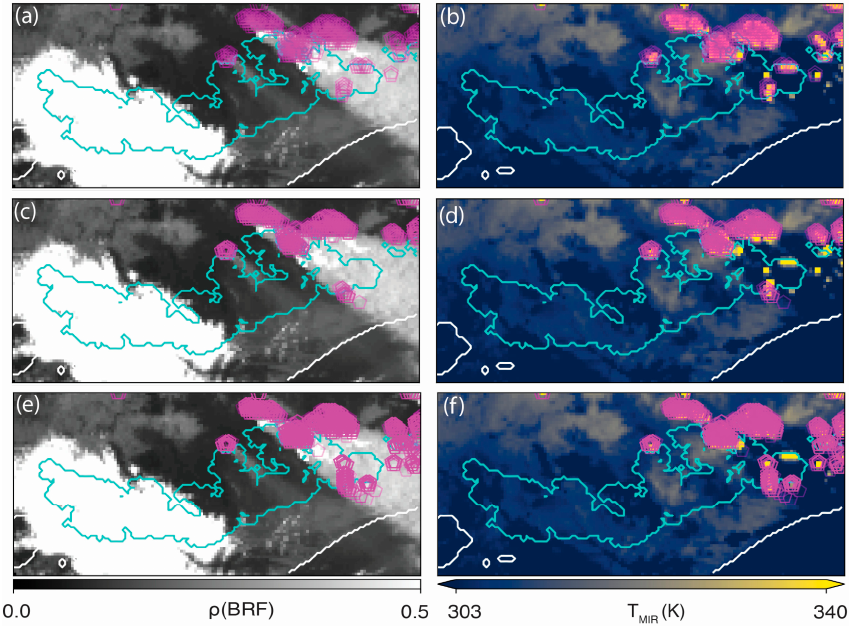
Figure 9. BRIGHT ( a , b ), MODIS ( c , d ) and VIIRS ( e , f ) hotspots (magenta, semi-transparent) overlaid on AHI ρ ( a , c , e ) and T MIR ( b , d , f ) data) for 04 UTC on 4 January 2020. The plot is centered on region Highlands–Northern Fall (SEH01; aqua outline) (SEH01 falls in biodomain SEH as shown in Figure 6) and demonstrates an example of disagreement between BRIGHT, MODIS, and VIIRS during intense fire activity.